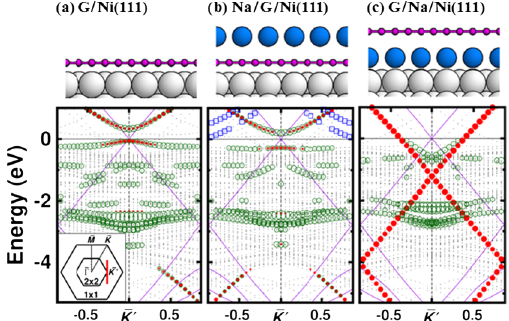
FIG. 4. Majority-spin band structures of (a) graphene/Ni(111), (b) Na(0.63 ML)/graphene/Ni(111), and (c) graphene/ Na(0.63 ML)/Ni(111). The vertical solid line in the surface Brillouin zone represents the calculated line. The Fermi energy is set to 0, and the bands of ideal graphene are given as the reference by the thin solid lines. The filled red (open green) circles represent C-derived (Ni-derived) surface states that contain more than 20% (40%) of charge in the graphene layer (topmost Ni layer). The size of the circles is proportional to the amount of charge localized in the graphene and the Ni layer. Open blue squares represent the Na-derived surface states that contain more than 5% of charge in the Na